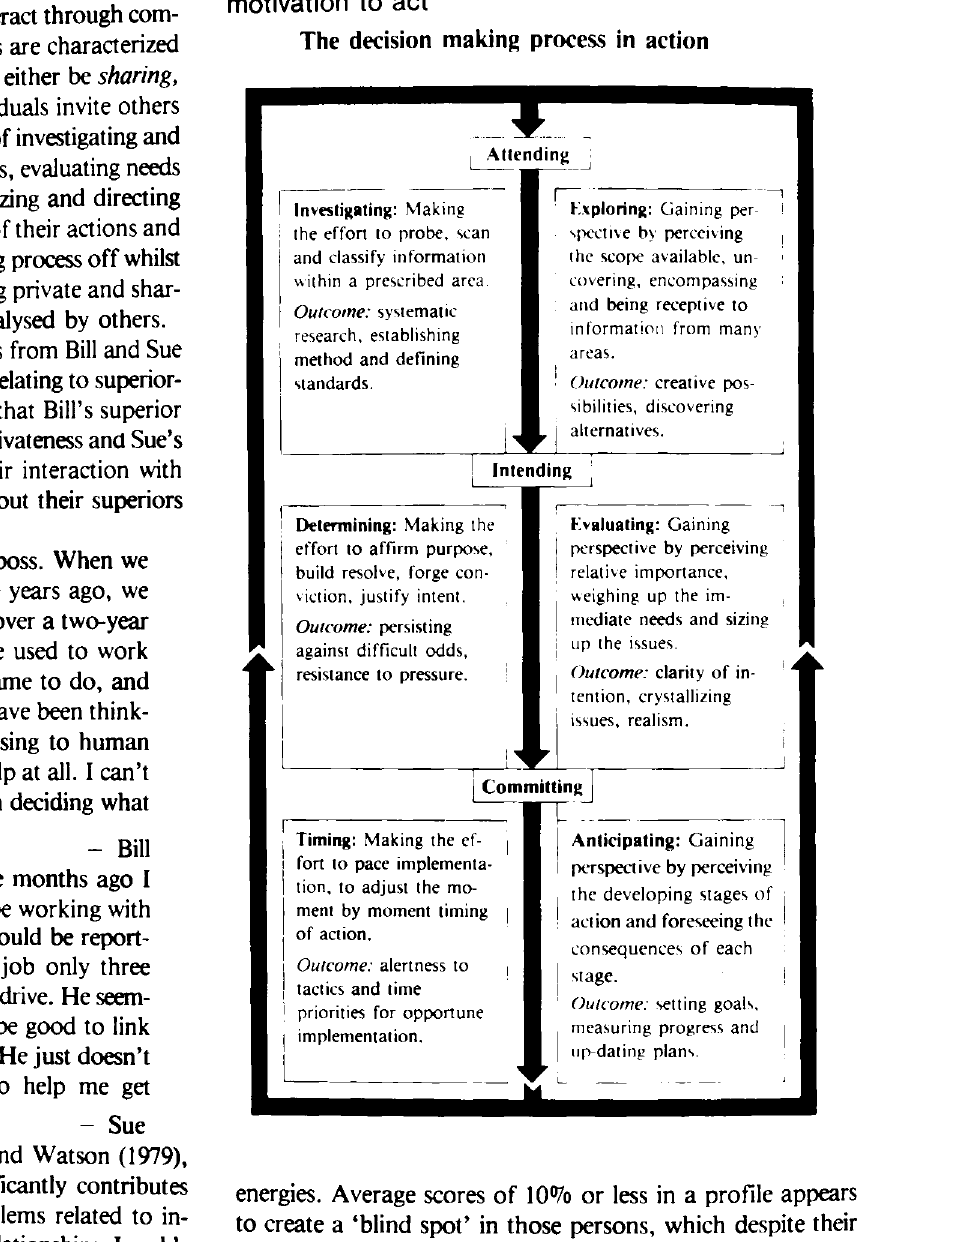
Table 4 Framework of management initiative: the motivation to